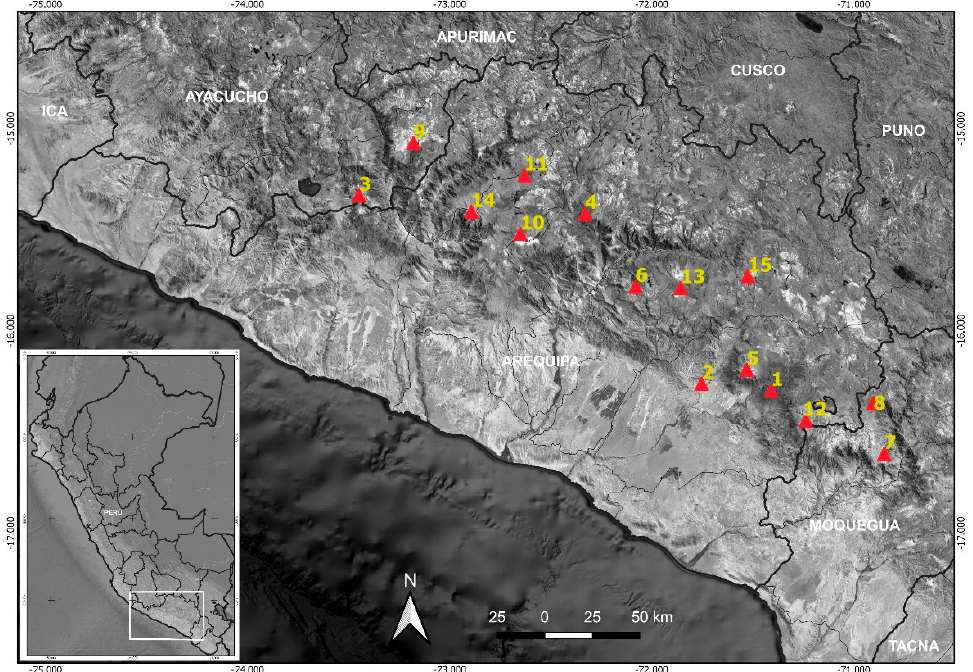
Figure 1. Distribution map of the volcanoes of the Arequipa Region, northwestern Moquegua